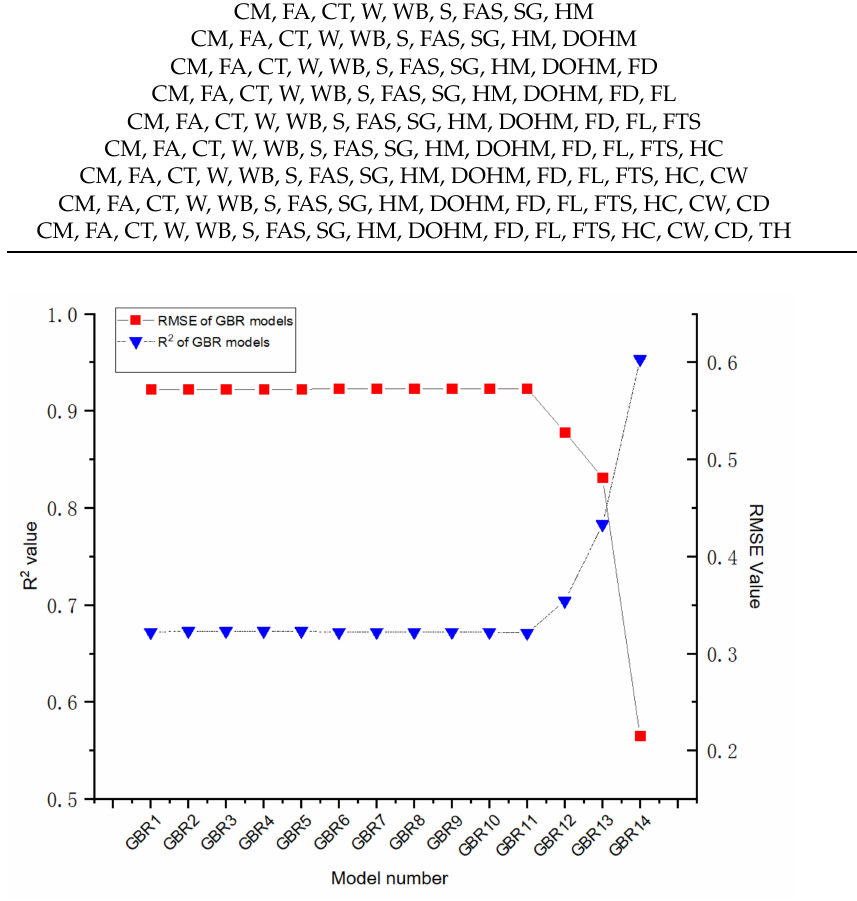
Figure 6. R 2 and RMSE of GSA-GBR models